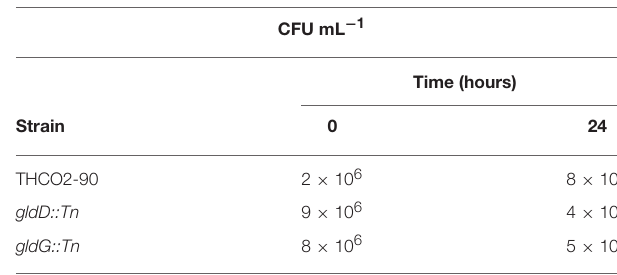
TABLE 6 | Bacterial loads in aquarium water during immersion